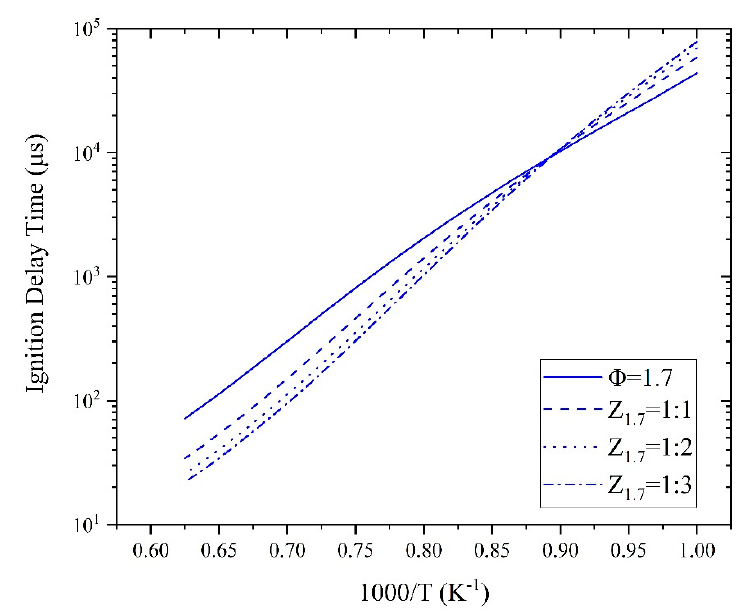
Figure 4. Comparison of the ignition delay times of n -pentane at an equivalence ratio of 1.7 and air– light hydrocarbon mixing gas at mixing degree of 1, 1/2, and 1/3, respectively.